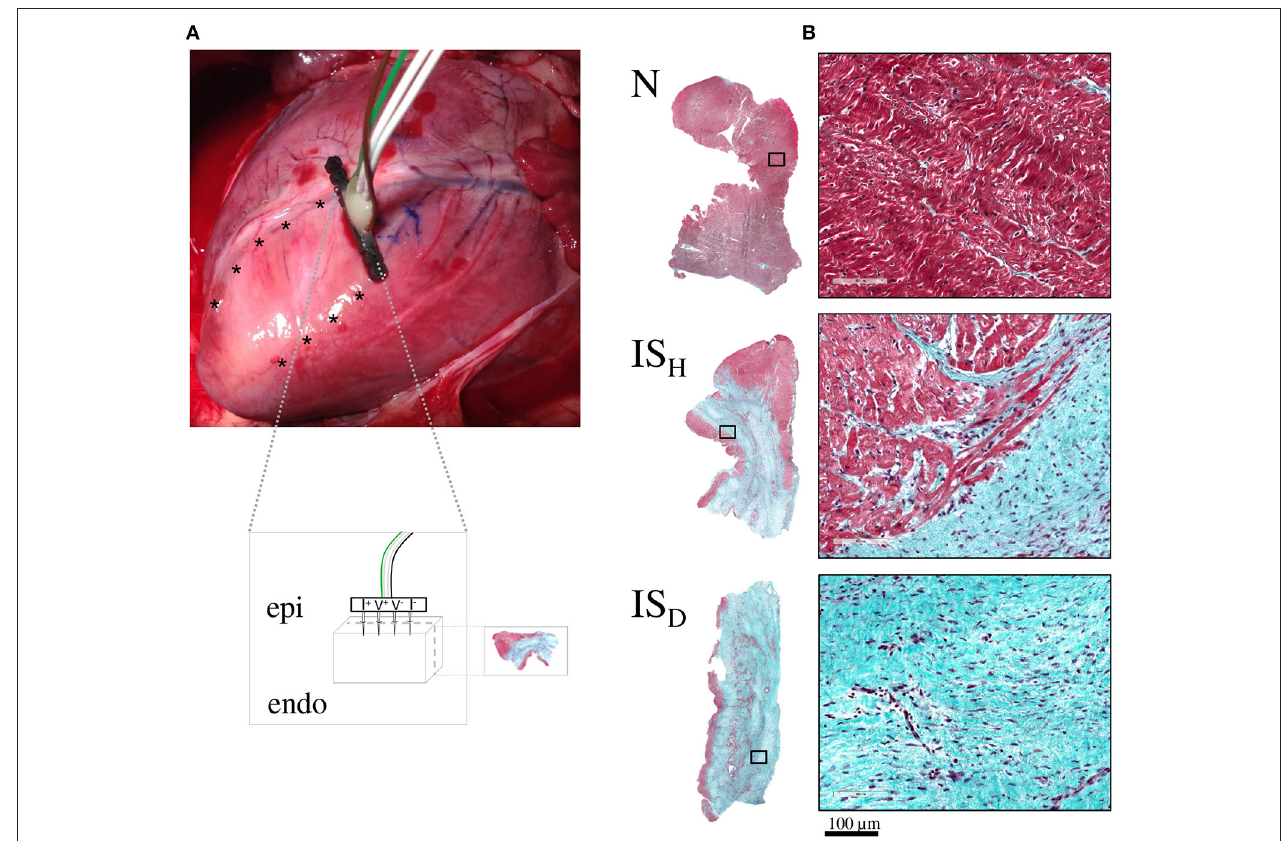
FIGURE 1 | Schematic representation of the experimental model. (A) Photograph of a swine heart illustrating the location of the infarcted region in the anterior wall of the left ventricle and the sites where the impedance electrode was sequentially inserted (asterisks). The inset box depicts a schematic representation of the 4-needle impedance electrode (5mm length spaced 1.27mm, 0.4mm diameter). (B) Representative microphotographs (at 1x and 20x magnification) of myocardial samples from normal zones (N) and from heterogeneous and dense infarct scar regions (IS H and IS D , respectively) stained with Masson’s trichrome.